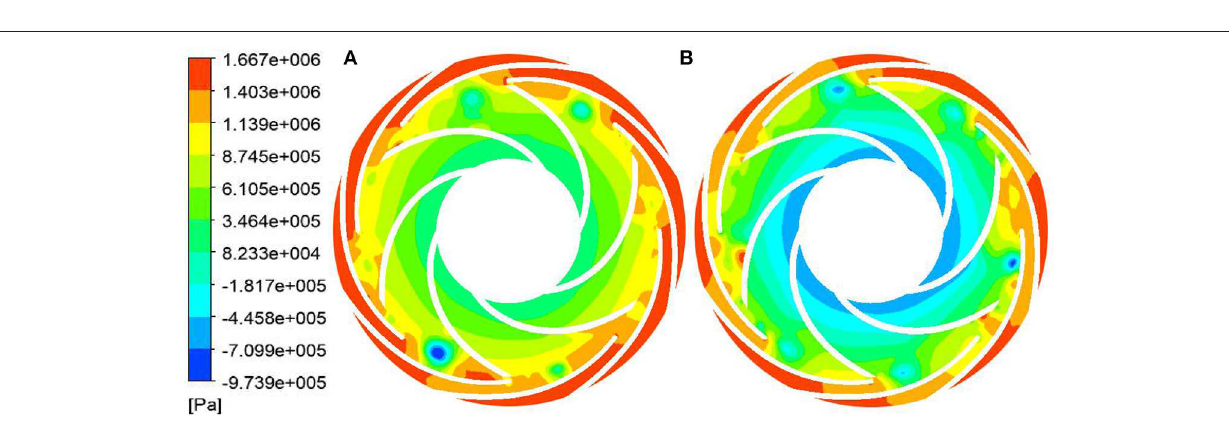
FIGURE 11 | Static pressure distribution of the first stage impeller with n = 2,985 r/min. (A) Start-up transient of closed-valve and (B) steady state at the same